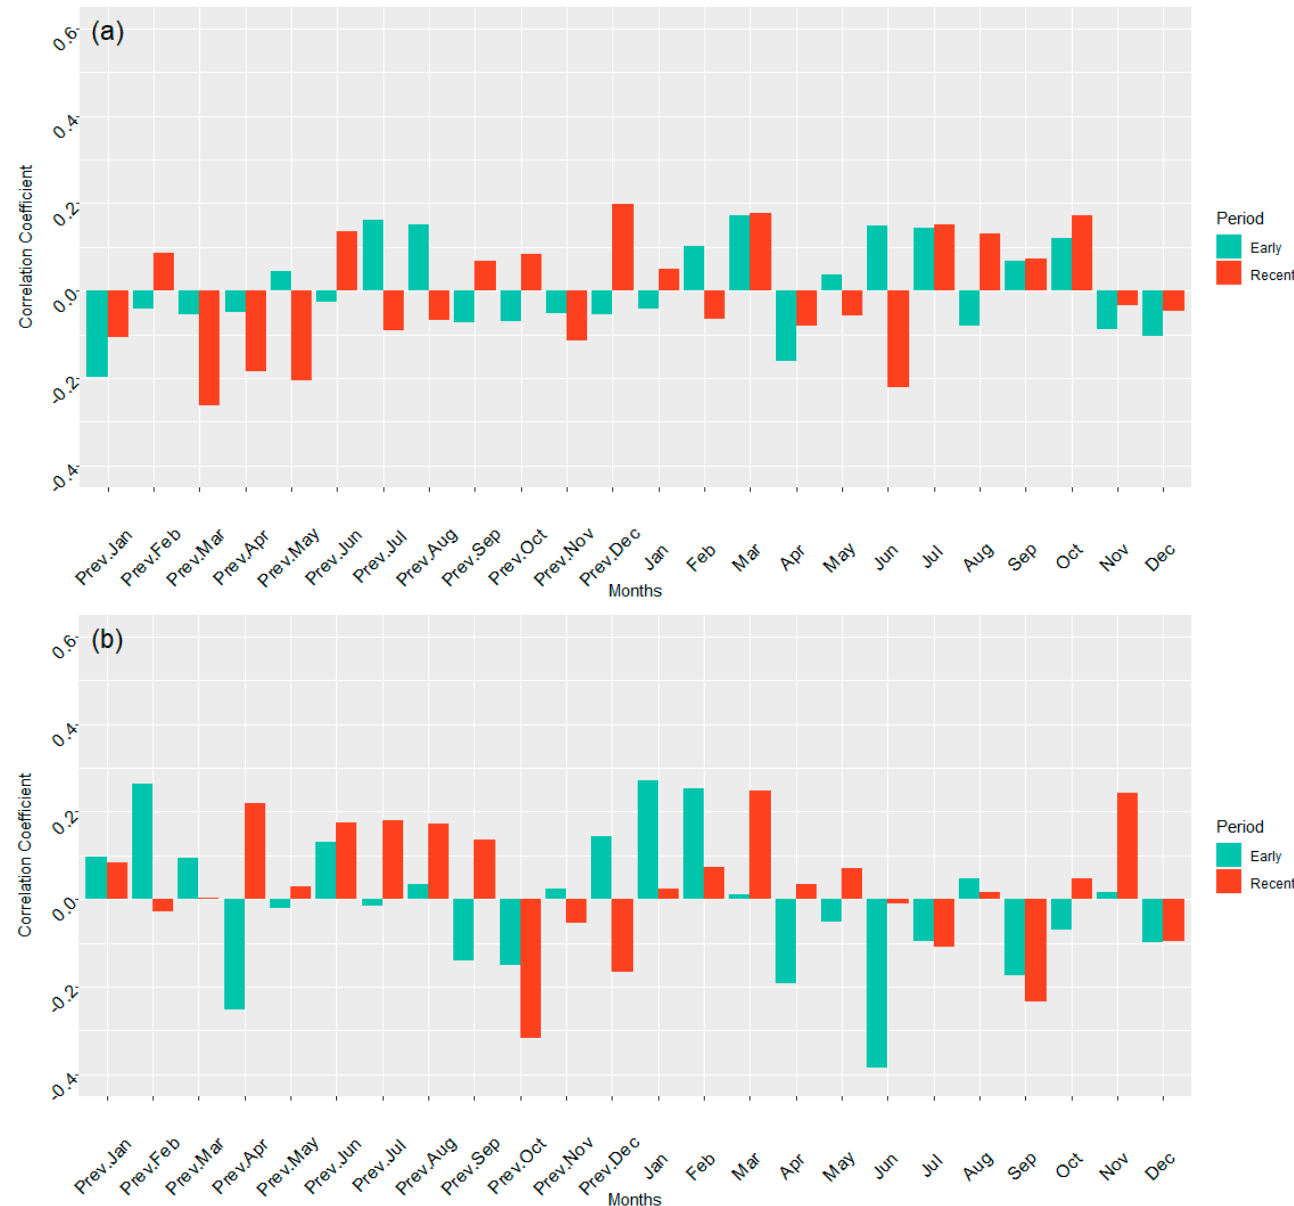
Figure 4. Spearman correlations in each month of 24-month window (12 months in the current year and 12 in the previous year) based on standardized tree ring chronology and average monthly temperature for ARNWR ( a ) and GDSNWR ( b ) sites. Each site is further divided into time periods including early (pre-1972, teal) and recent (post-1972, red). Significant correlations are denoted by “*” and colors correspond with periods.